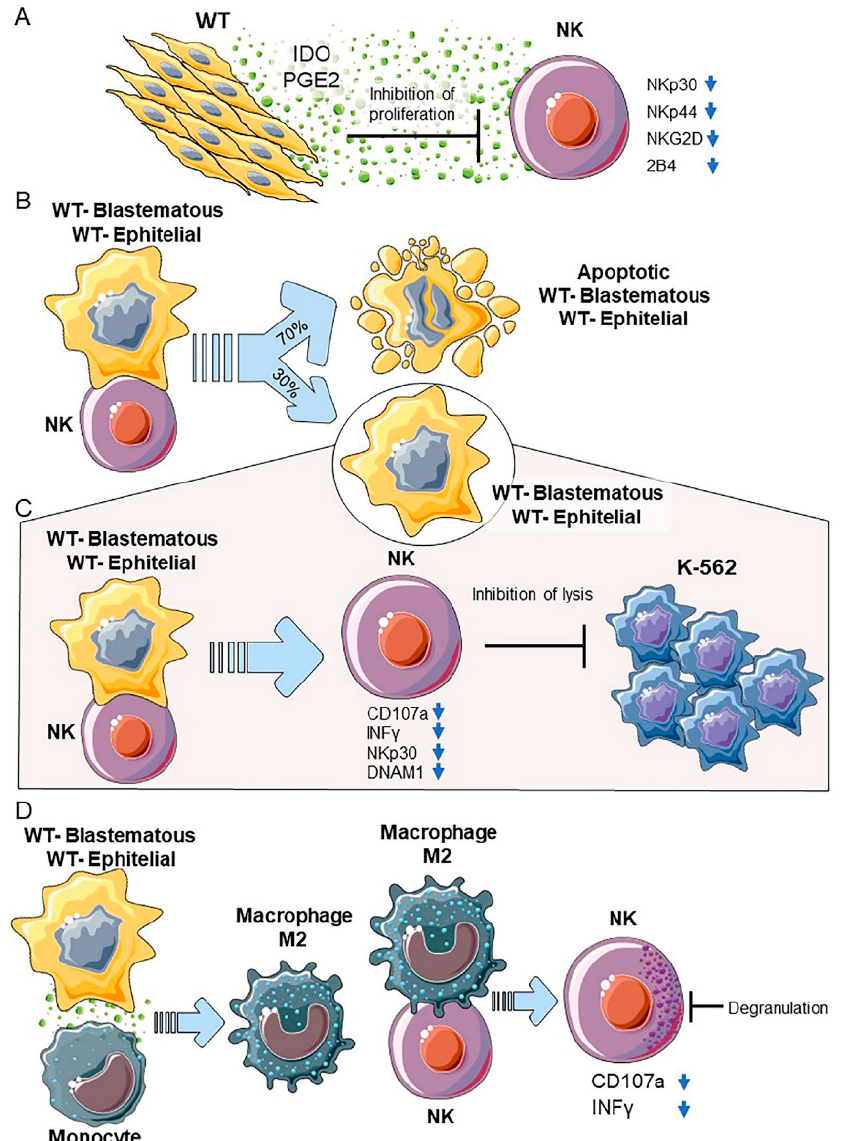
Figure 2. ( A ) WT-MSC cells inhibit the cytokine-induced proliferation of NK cells and the up-regulation of NKp30, NKp44, NKG2D and 2B4 through the secretion of the soluble immunoregulatory factors IDO and PGE2. ( B ) Efficient NK-mediated lysis (70%) of WT-blastemal and WT-epithelial cells. ( C ) 30% surviving WT-blastemal and WT-epithelial cells after 4 days of coculture, efficiently inhibiting the lytic function of activated NK cells against the K-562 target cells. ( D ) WT-blastemal and WT–epithelial after 6 days of coculture with PB-monocytes, inducing their polarization into M2 macrophages. M2 macrophages after 3 days of coculture with freshly isolated NKs inhibit their production of CD107a and IFN- γ .